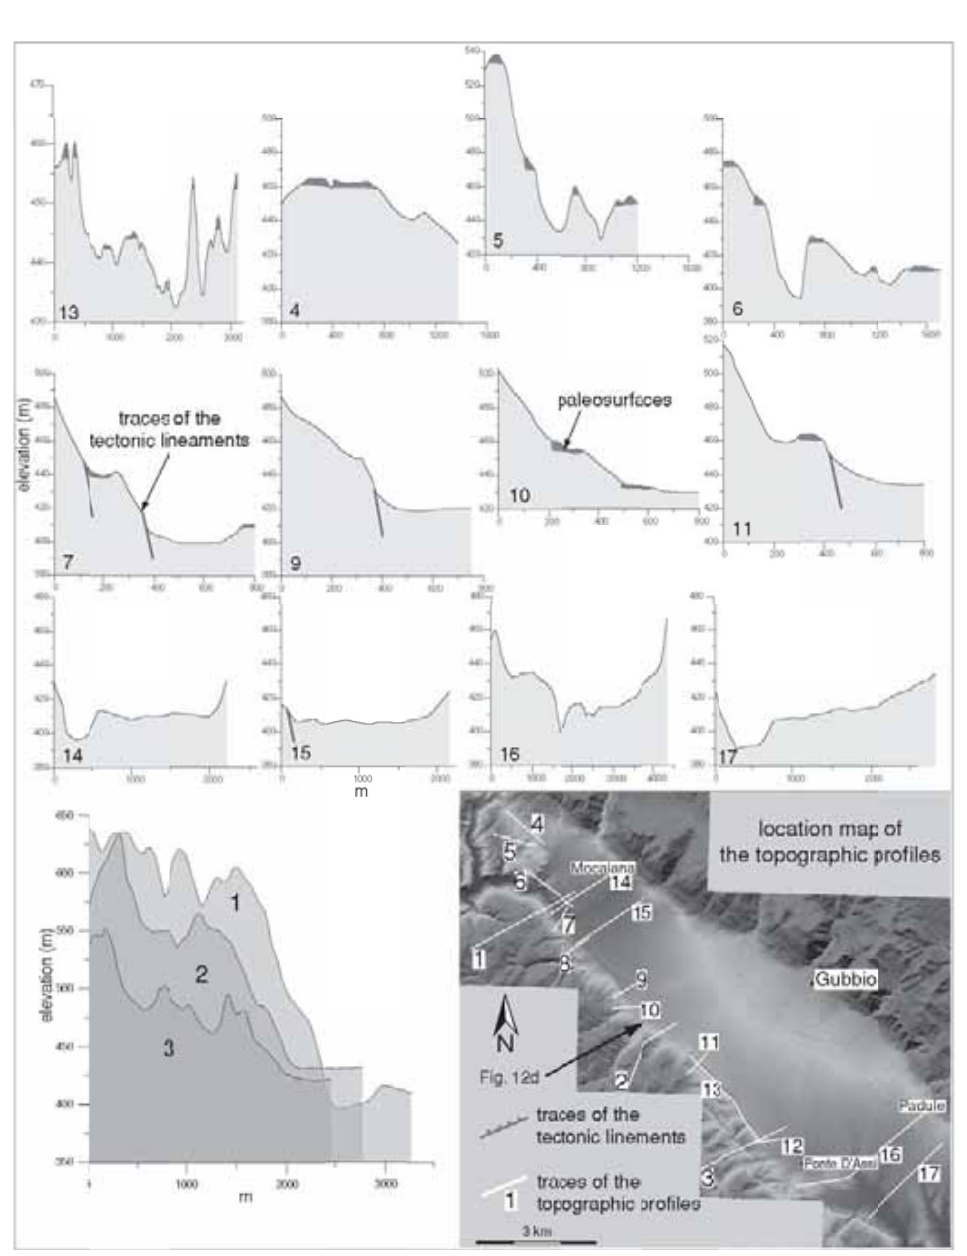
Fig. 11. Detailed topographic profiles, across and along the western slope of the basin, performed from 5-m resolution DEM. The location of the main paleosurfaces (dark gray) together with the traces of the observed tec- tonic lineament is shown. Profile 1, 2 and 3 are shown in overlap to highlight the elevation decrease of the paleo- surfaces between north and